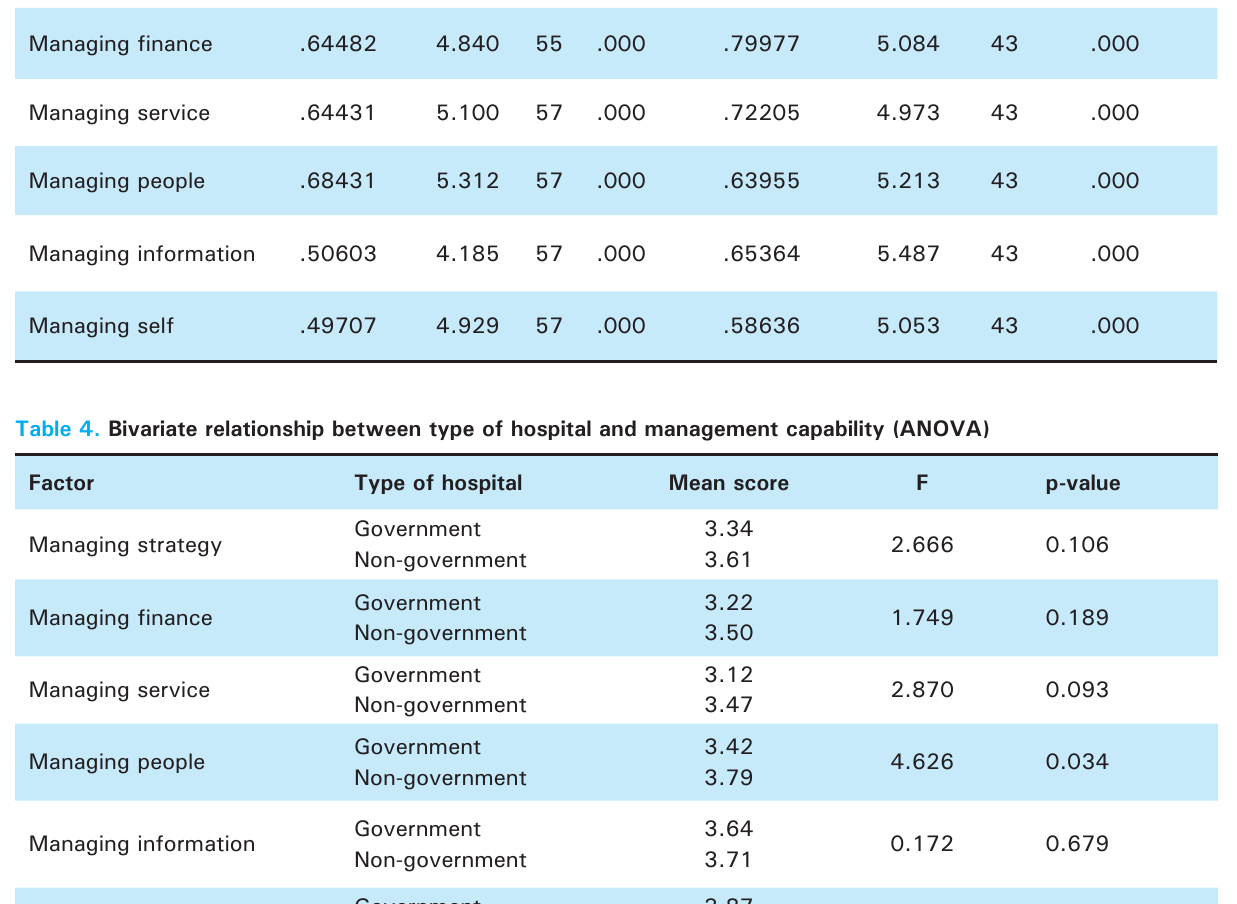
Table 5. Views about management and working Two thirds (66%) of government managers ‘strongly agreed’ that they would work better if they had greater autonomy compared to 36% of non-government of